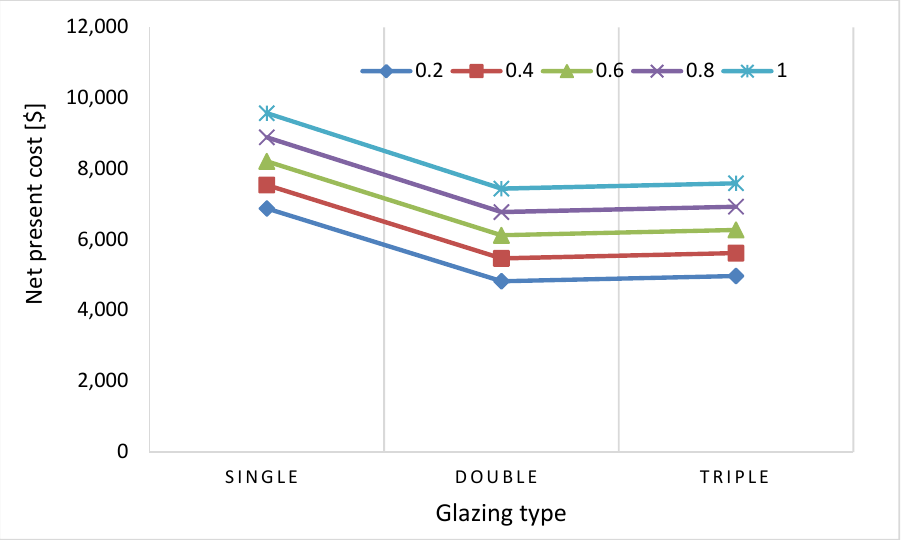
Figure 16. The influence of the infiltration rate on the net present cost for Istanbul.